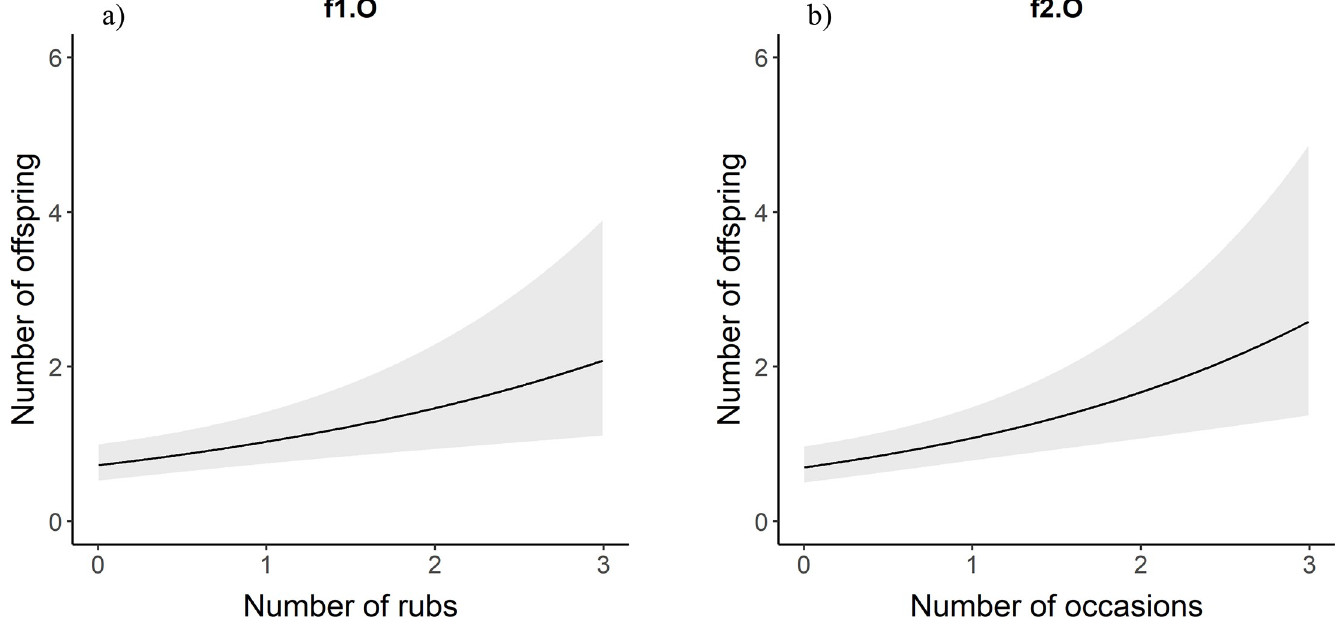
Fig 6. f1.O and f2.O. Poisson regression response curves showing the relationship between the number of offspring a female brown bear had and the number of rubbed objects (a) at which and sampling occasions (b) during which it was detected. Confidence intervals are in grey. Data are from southwestern Alberta 2011–2014.